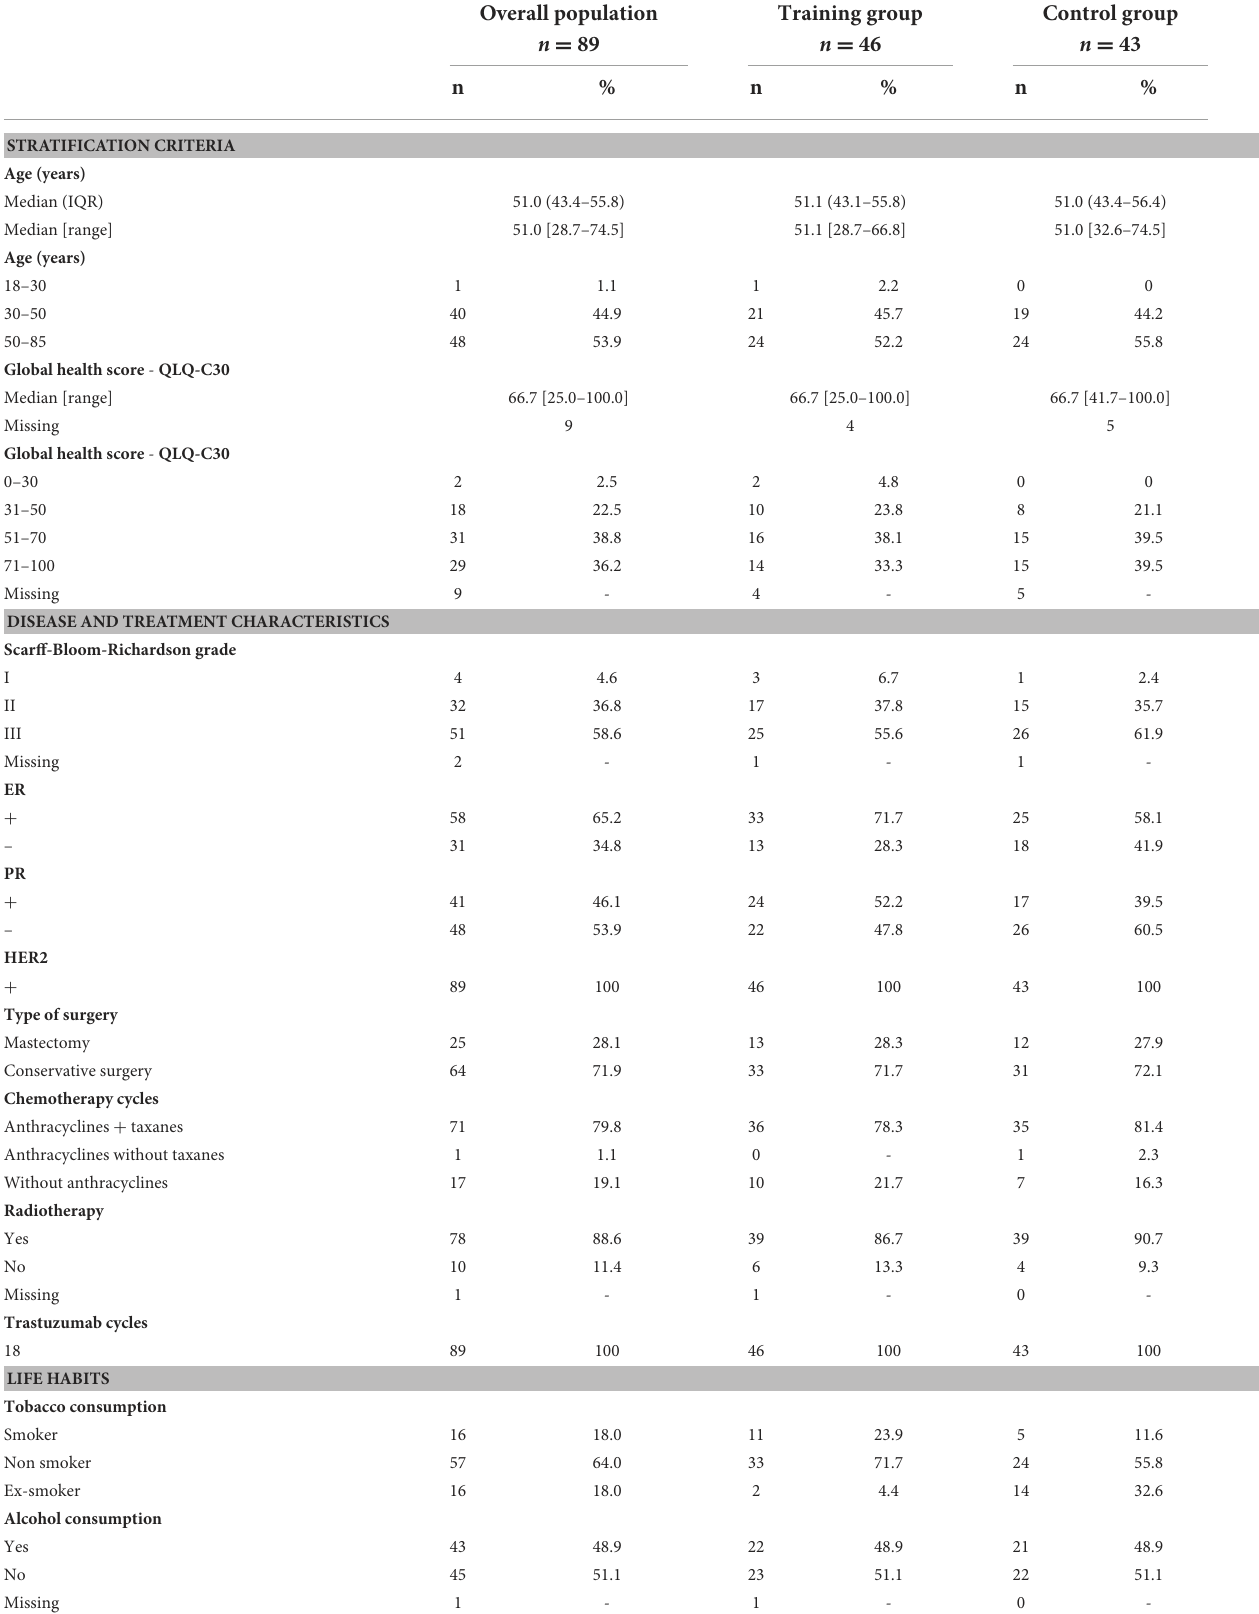
TABLE 2 Patient’s characteristics at